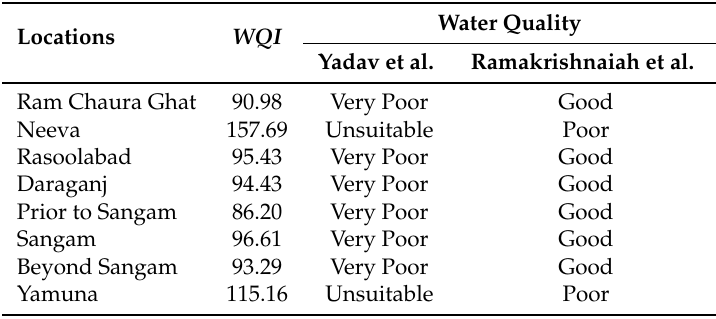
Table 3. Water Quality Indices and Water Quality at different locations